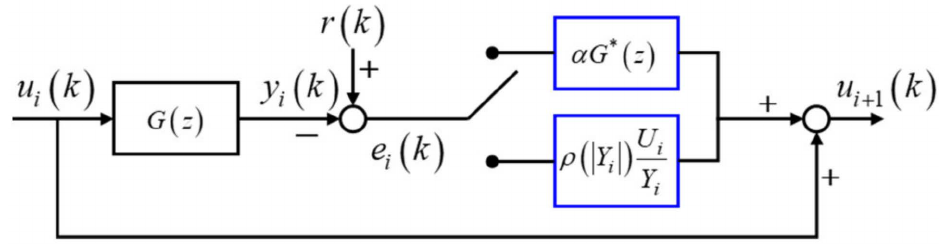
Figure 4. Schematic diagram of gain switching structure of control algorithm learning law proposed in this